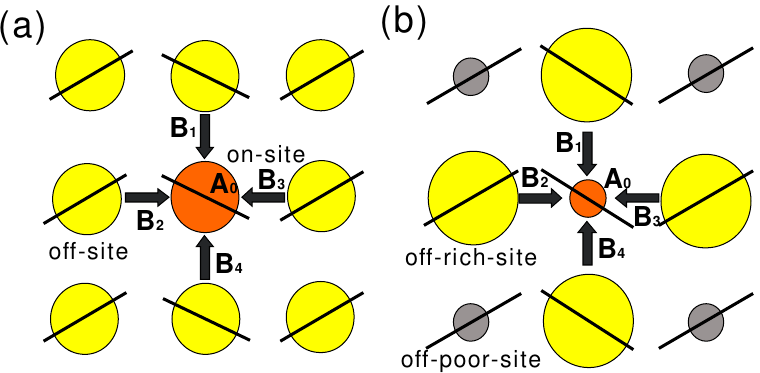
Figure 7. Schematic view of hyperfine coupling field around the neighboring molecules ( a ) in no disproportionation ( b ) in disproportionation of diagonal stripe pattern with on-site and B ( i = 1, 2, 3, 4) are the on-site and off-site hyperfine coupling spin poor site. Here A i 0 fields.